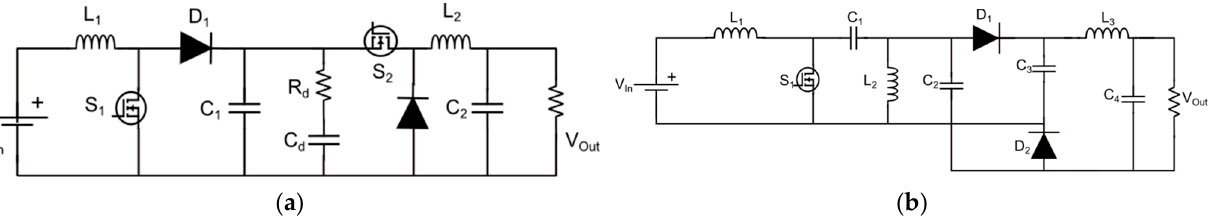
Figure 7. Two-switch boost-buck converter (TSBb) ( a ). Novel high gain single-switch DC-DC buck- boost converter with continuous input and output power (NISBb) ( b ). boost converter with continuous input and output power (NISBb) ( b